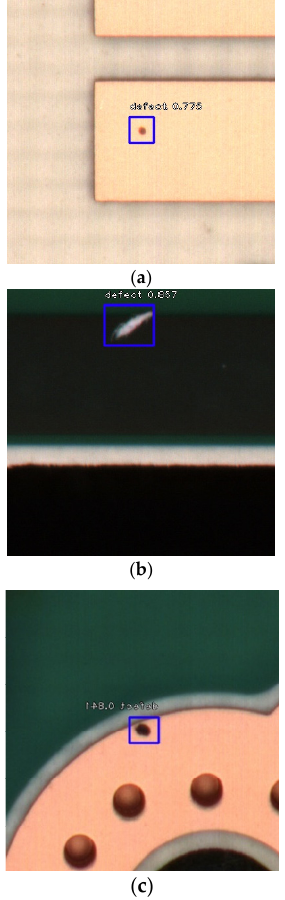
Figure 8. True positive PCB sections: ( a ) True positive PCB sample 1. ( b ) True positive PCB sample 2. ( c ) True positive PCB sample 3.